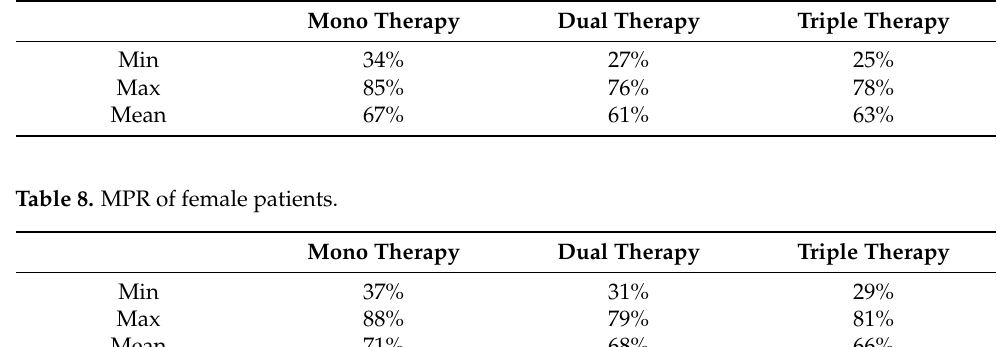
Table 7. MPR of male patients.